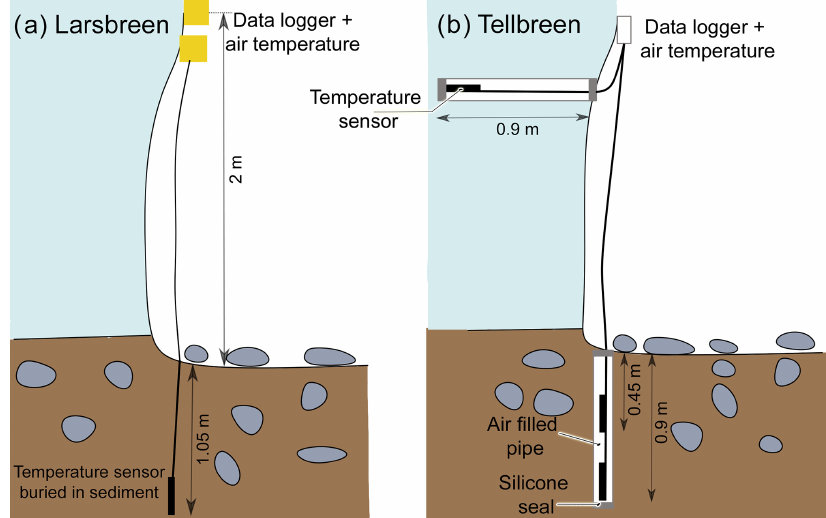
Figure 5. Logger setup at Larsbreen and Tellbreen. (a) The sediment temperature sensor was buried directly into the sediment at Larsbreen. (b) Temperature sensors in ice and sediment were encapsulated in an air-filled PVC pipe (20mm diameter) at Tellbreen. The ends of the pipe were sealed off with silicone.